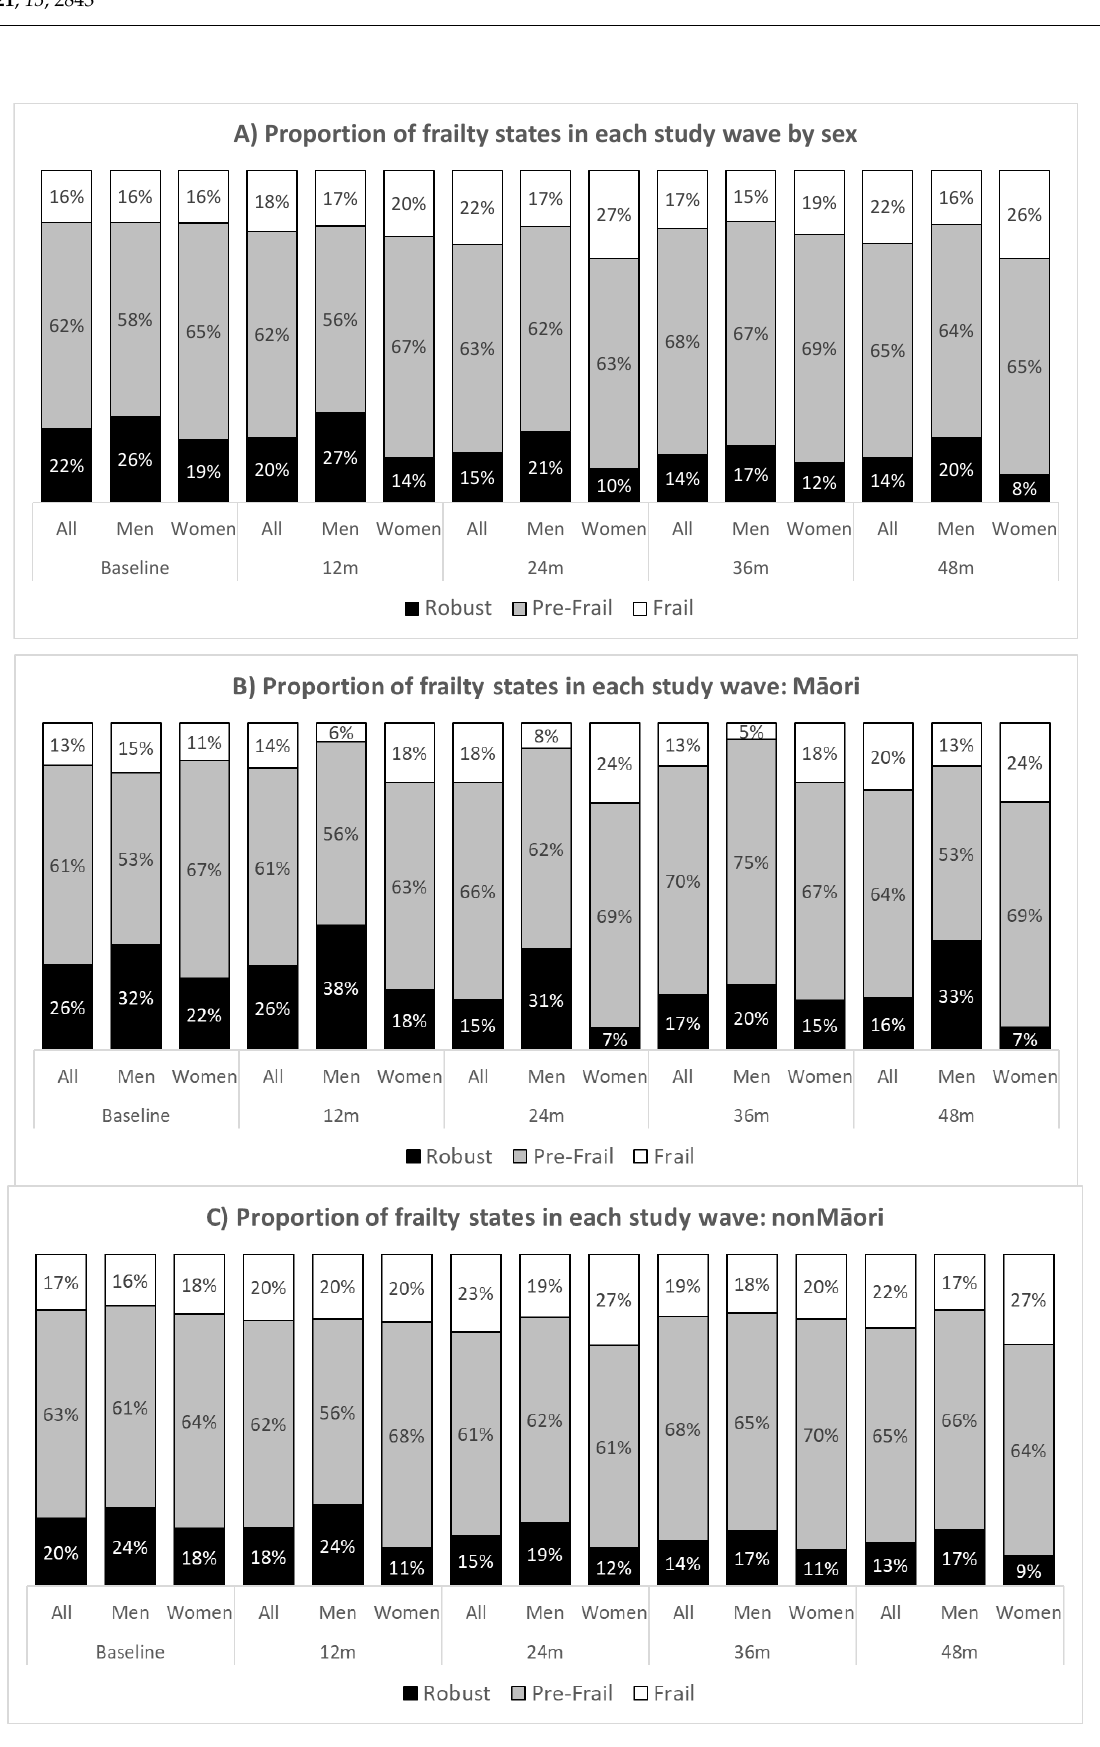
Figure 1. Frailty states by sex ( A ) and ethnicity: M¯aori ( B ) non-M¯aori ( C ) for all five